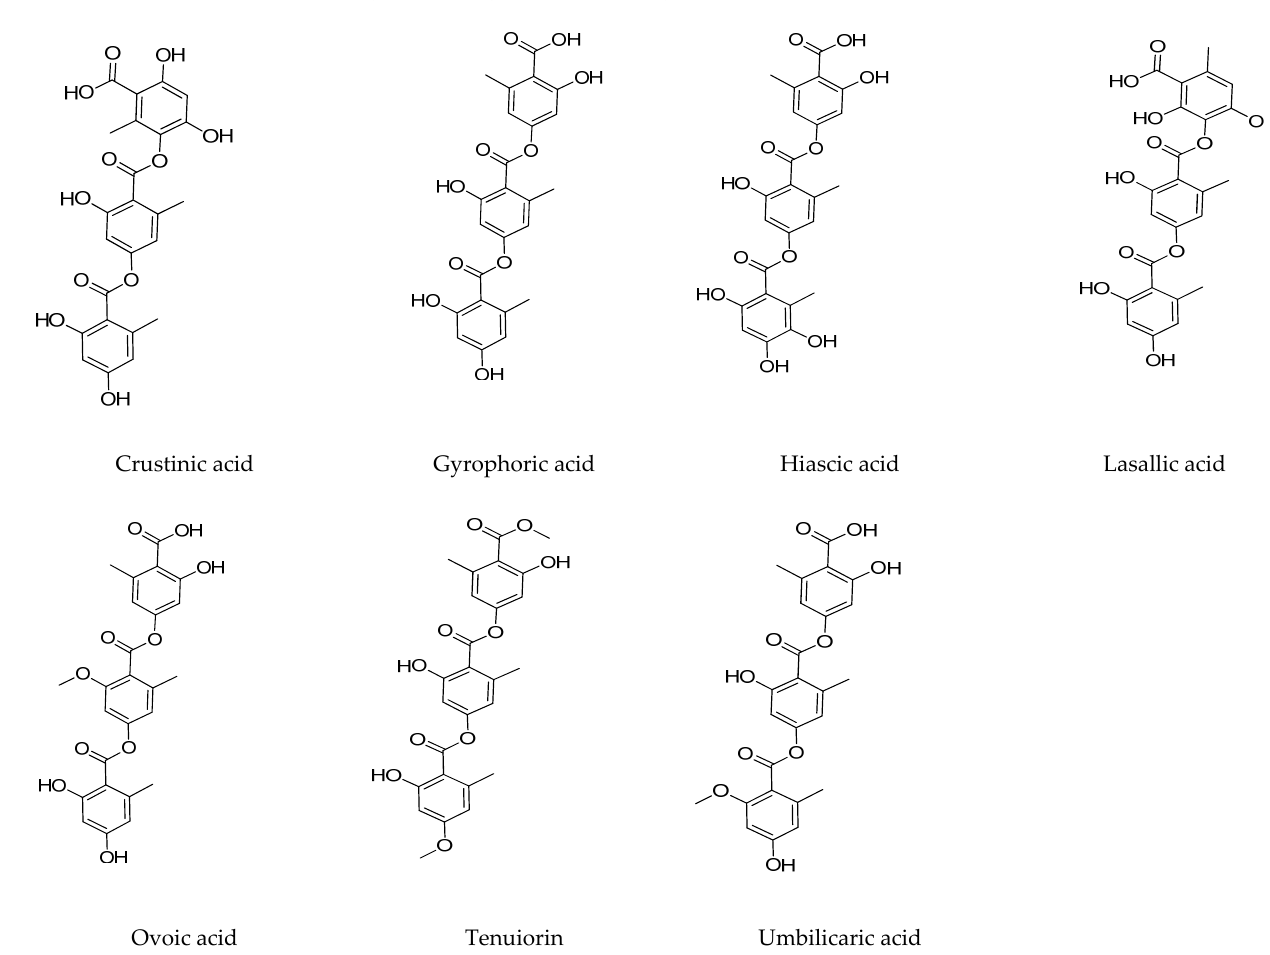
Figure 2. Chemical structure of tridepsides from lichens.